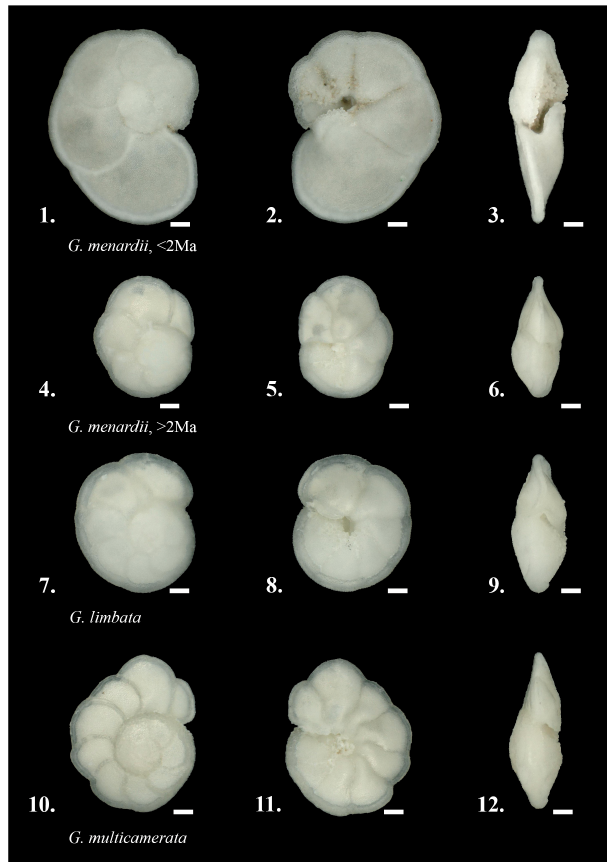
Figure 4. The investigated species in spiral, umbilical and keel view. 1–3: Globorotalia menardii , typically found during the past 2Myr in the Atlantic Ocean, sample 667A-1H-1, 3–4cm,